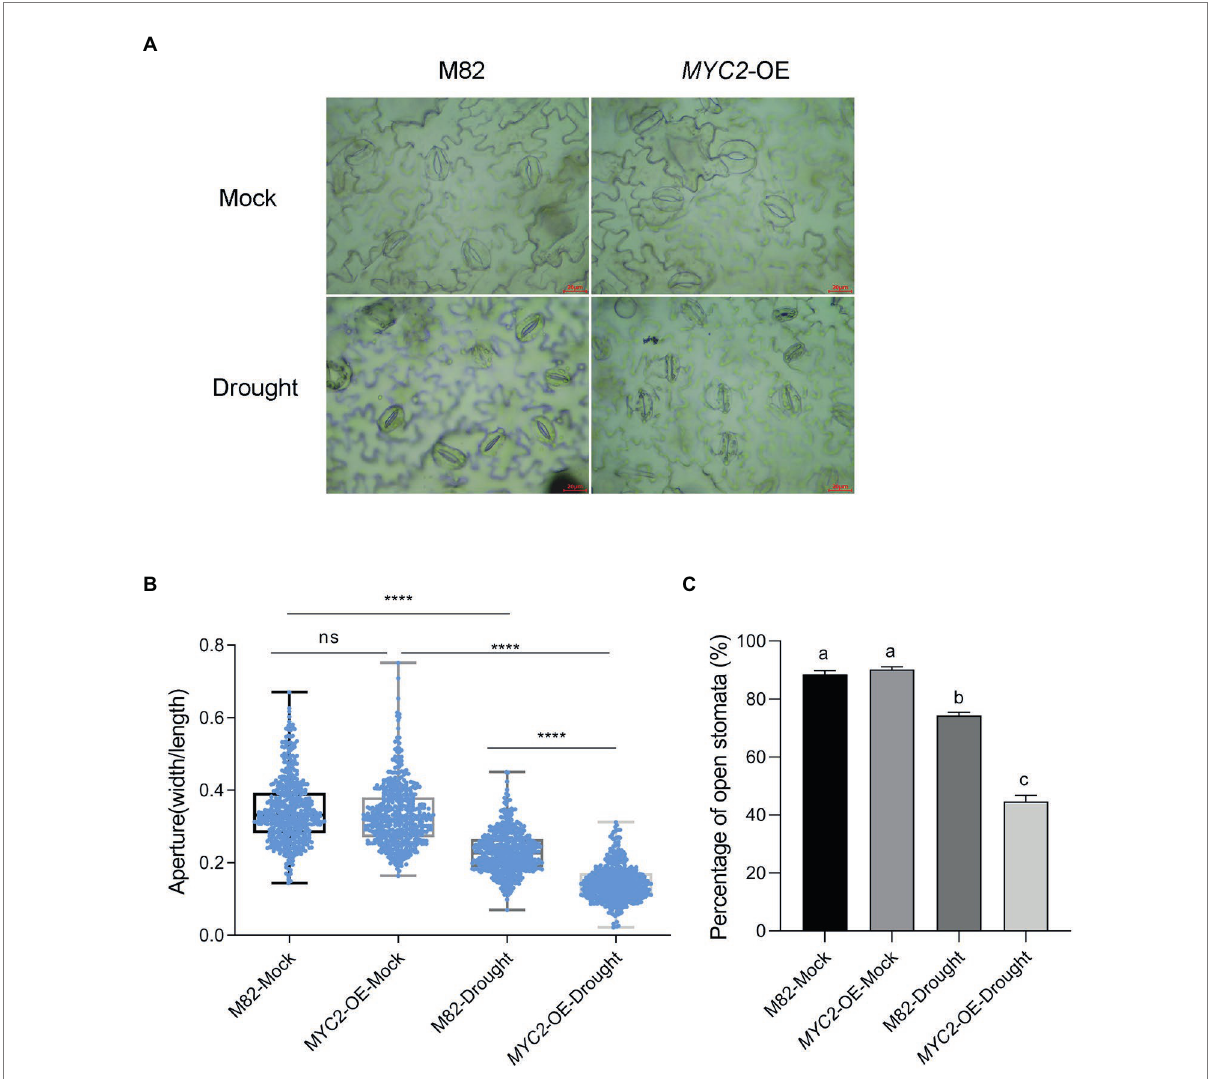
FIGURE 3 Overexpression of SlMYC2 promoted stomatal closure in plants under drought stress. (A) Typical images of stomata of MYC2 -OE and M82 plants after 8 days of water loss. (B) Stomatal aperture of MYC2 -OE and M82 plants with and without 8 days of water loss (M82: n = 506; MYC2 -OE: n = 501; M82-Drought: n = 504; MYC2 -OE-Drought: n = 501). Data were obtained from three independent experiments (bar = 20 μ m). (C) The percentage of open stomata in MYC2 -OE and M82 plants with and without 8 days of water loss (170 for each replicate, three replicates, n = 510). Asterisks and different letters represent significant differences ( p < 0.0001) based on Tukey’s multiple comparisons